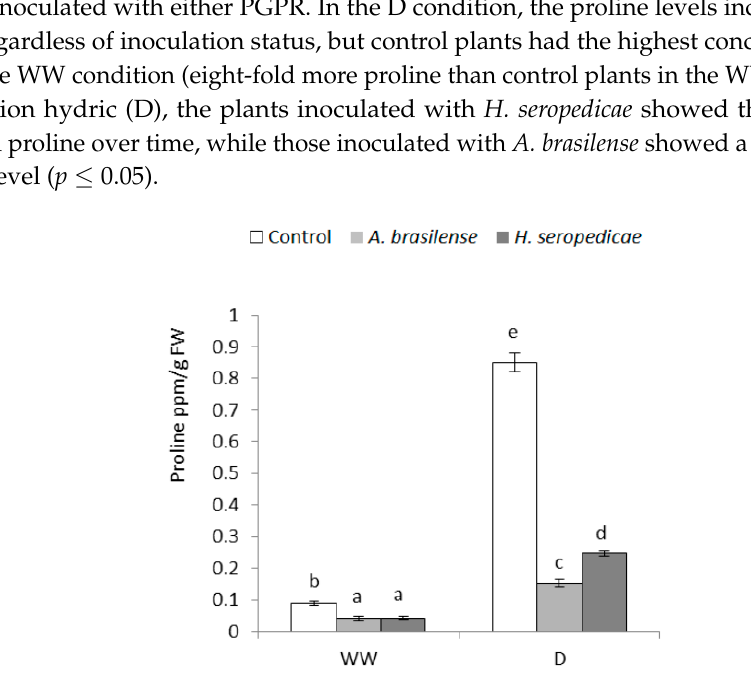
Figure 7. Proline concentration 20 DAS. Data are shown as means ± SD ( n = 24). Means with common letters are not significantly different ( p > 0.05). The plants were cultivated under WW or D conditions. The inoculation * drought interaction p <